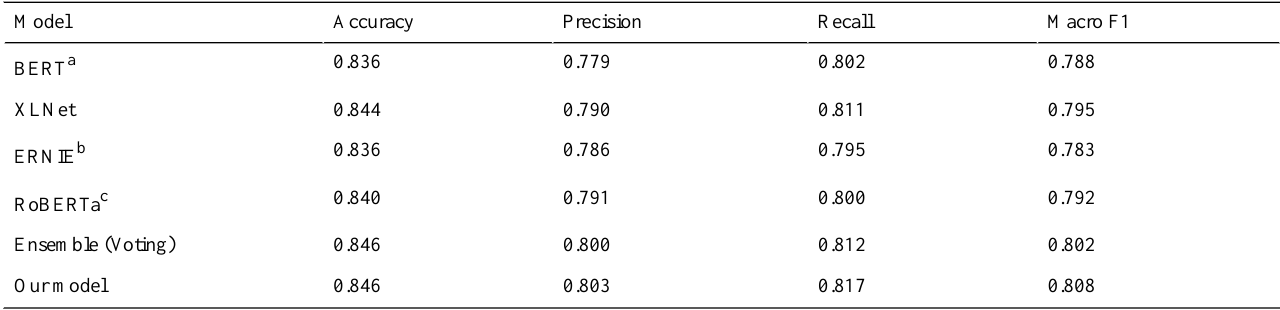
Table 2. The performance of our model and baseline models using the full training data